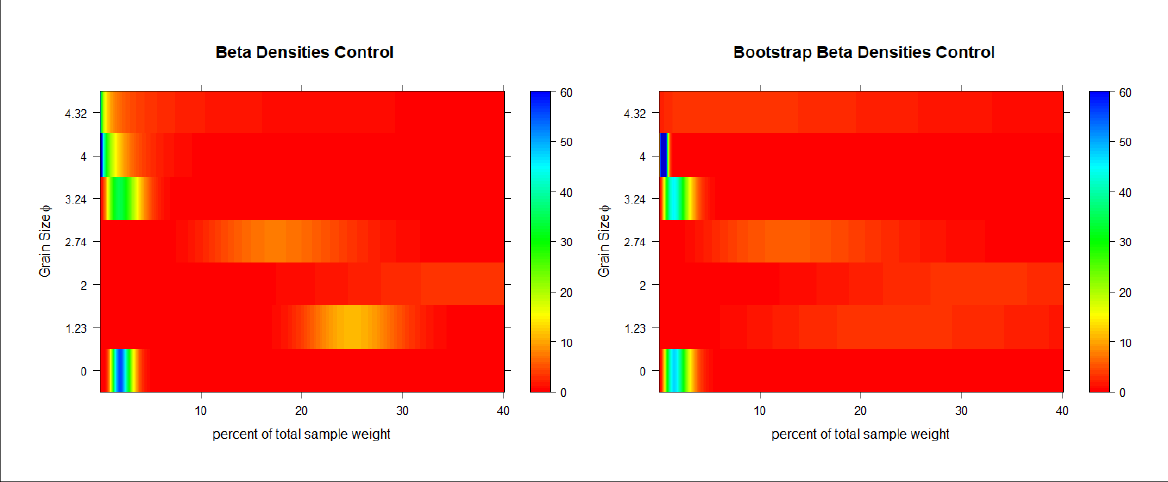
Figure 4. Control test—heat maps of original samples and bootstrap samples.